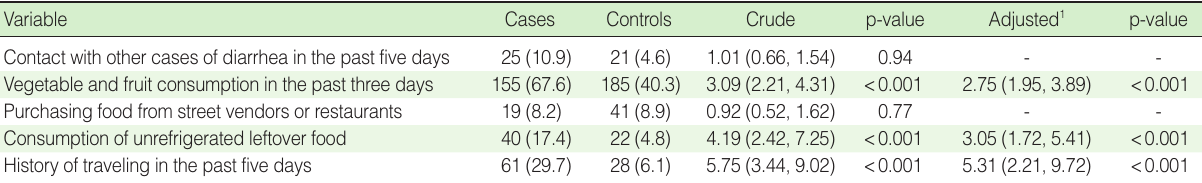
Table 3. Analysis for selected potential risk factors of cholera infection